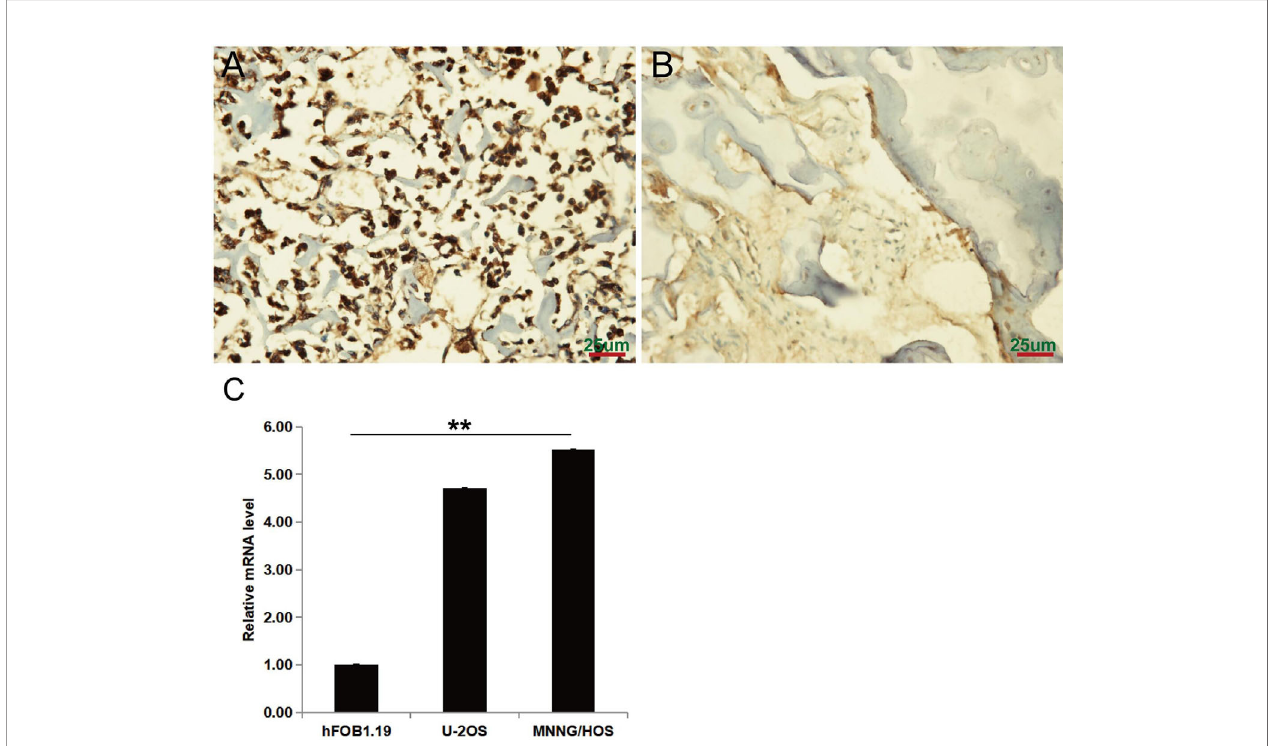
FIGURE 1 | PAFAH1B3 expression in osteosarcoma tumor and adjacent non-tumor tissues. (A) Representative images of immunohistochemical staining for PAFAH1B3 in osteosarcoma tumor tissues, strong expression. (B) Representative images of immunohistochemical staining for PAFAH1B3 in adjacent non-tumor tissues: absent expression. Original magni fi cation: 400×. (C) High expression of PAFAH1B3 mRNA level in U-2 OS and MNNG/HOS cell lines. Data were expressed as the mean ± s.d., ** P <